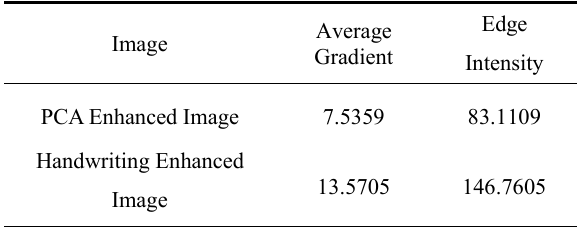
Figure 6. Comparison of handwriting enhancement methods